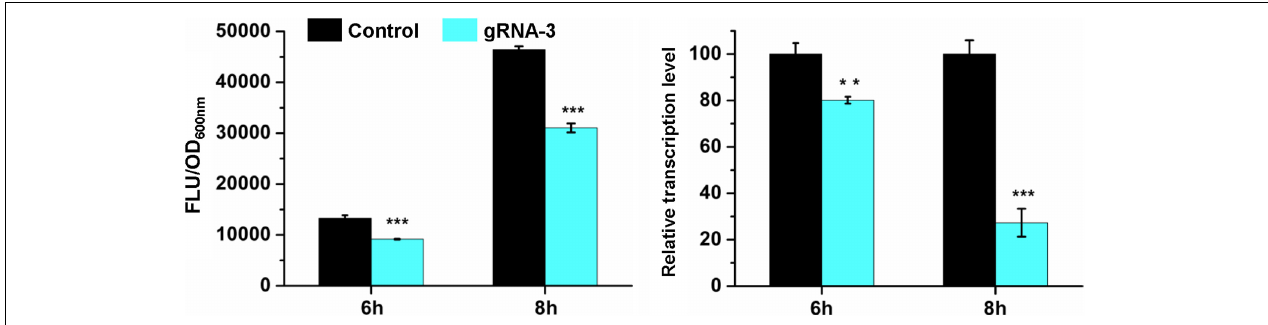
FIGURE 3 | CRISPR/CasRx-mediated mRNA knockdown. pCasRx-3 and pgRNA-3 were co-transformed into E. coli harboring pGFP for gene repression. Inducer (200 ng/mL Tc) was added at the beginning of cultivation to induce casRx expression. Cells were collected at 6 and 8 h for GFP fluorescence and mRNA determination. Error bars indicate standard deviations from three parallel experiments. All t -tests compare the GFP fluorescence per OD 600 nm or gfp transcription level using gfp -targeting gRNA-3 against non-targeting gRNA control (** P < 0.01, *** P <